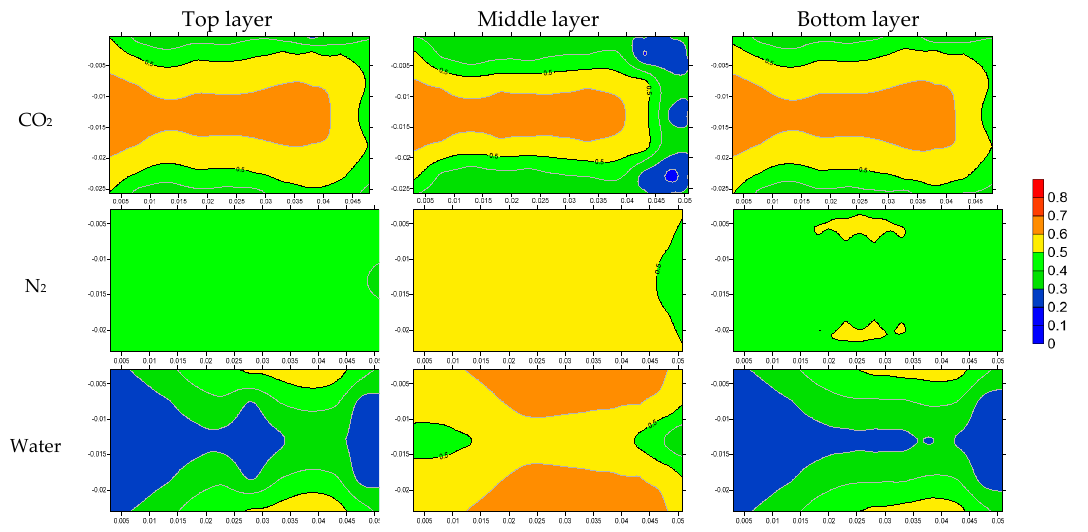
Figure 24. Oil recovery comparison with gravity effect.